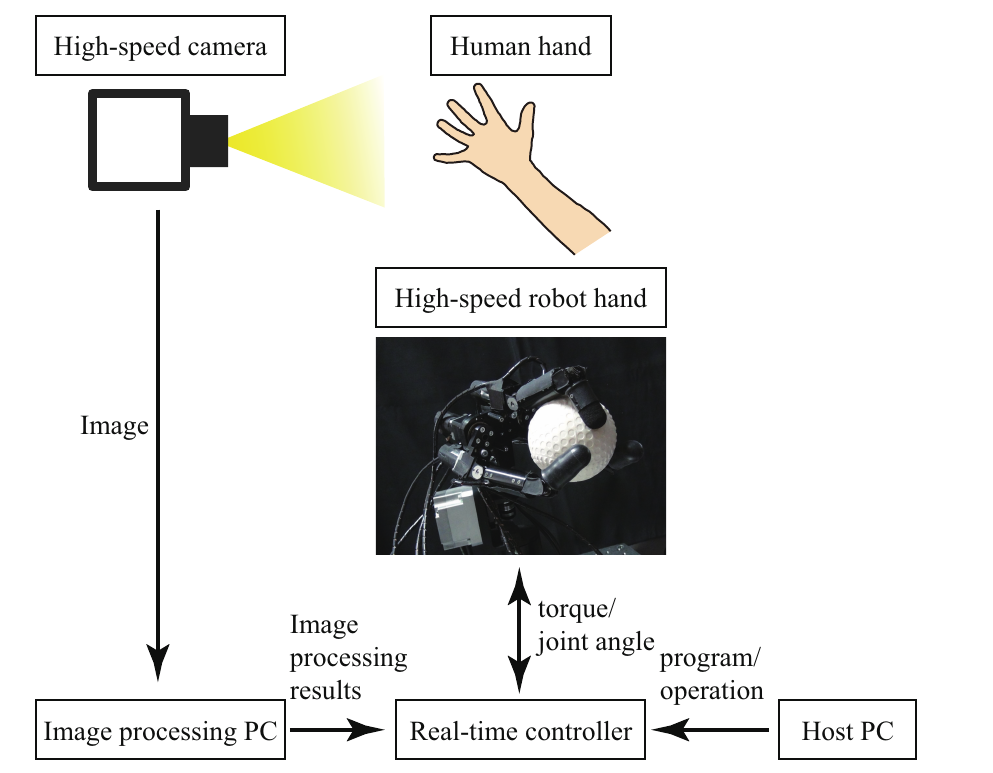
Figure 1. Structure of the experimental